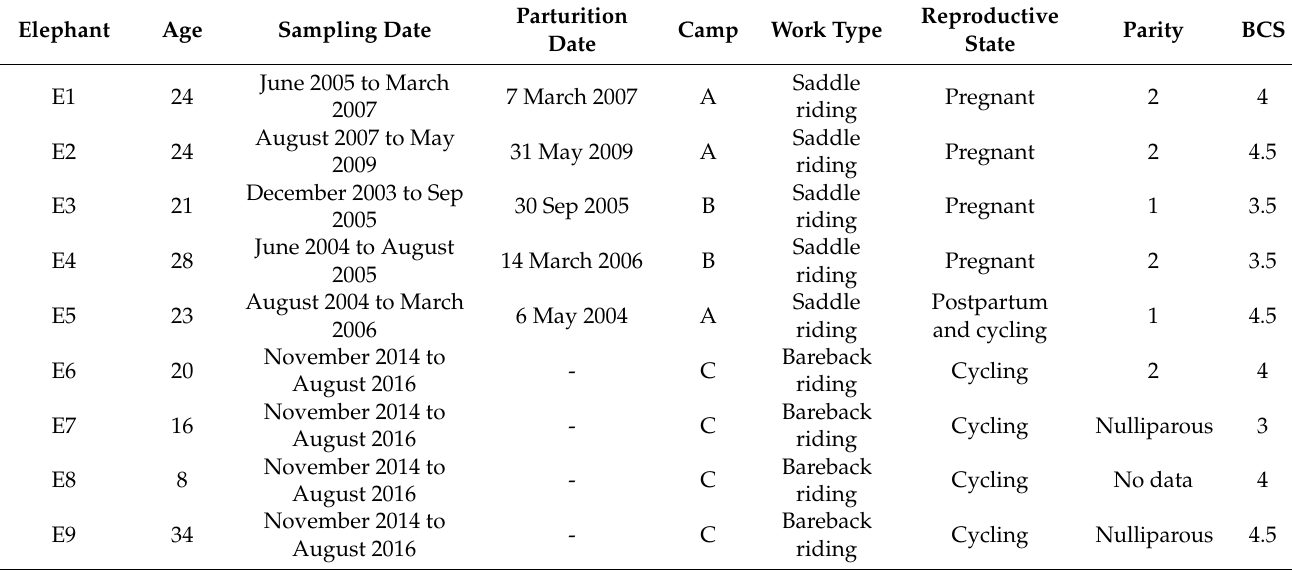
Table 1. Summary of the demographics, reproductive status, work activities, and body condition scores of elephants evaluated in the